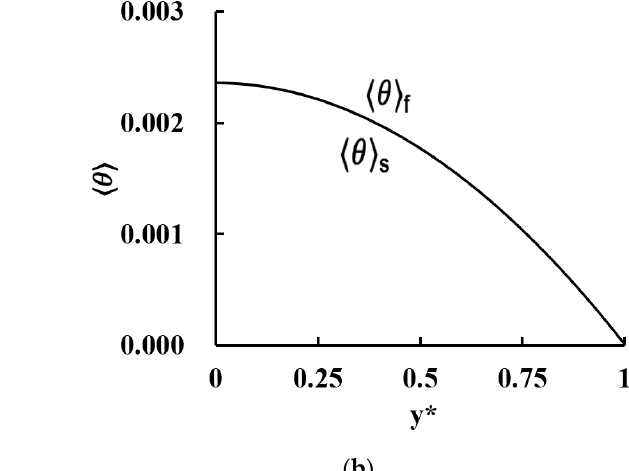
The changes of the channel Nusselt number with channel Reynolds number for SHC